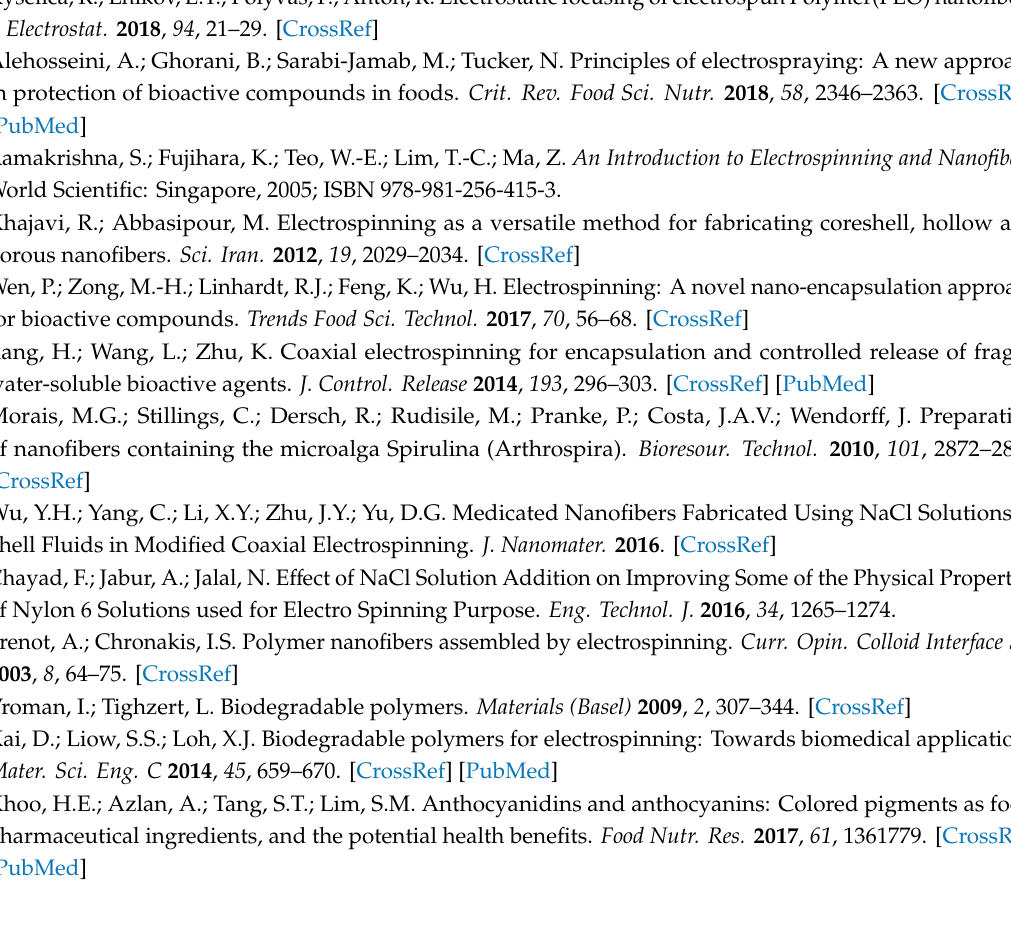
Figure S1: UV-Vis spectral characteristics of the PEO and PEO + NaCl solutions; Figure S2: Analysis of SEM micrographs corresponding segmented images original SEM images are presented in Figure 5) by DiameterJ’s Histogram algorithm and orientation degrees using OrientationJ, A: condition 1 (PEO 8%, without NaCl, TCD 10 cm, voltage 10 kV, feeding rate 150 µ · h − 1 ); B: condition 2 (PEO 6%, without NaCl, TCD 10 cm, voltage 24 kV, feeding rate 150 µ · h − 1 ); C: condition 3 (E and F) (PEO 6%, NaCl 2.5%, TCD 10 cm, voltage 24 kV, feeding rate 3000 µ · h − 1 ) and D: condition 4 (G and H) (PEO 8%, without NaCl, TCD 15 cm, voltage 24 kV, feeding rate 3000 µ · h − 1